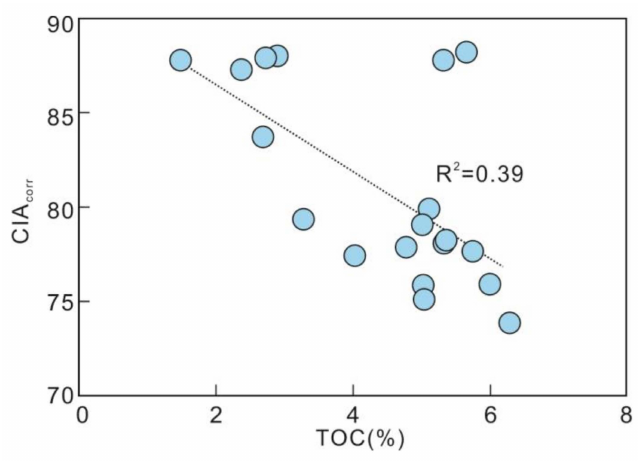
Figure 8. Crossplot of CIAcorr vs. TOC for the Meizwan sediments.